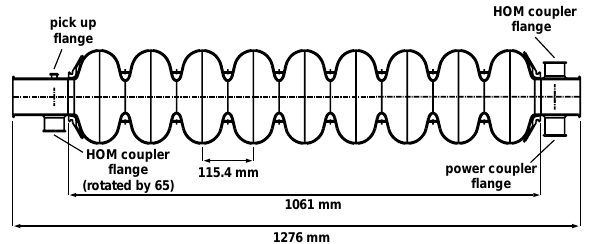
FIG. 5. Side view of the 9-cell TTF cavity with the ports for the main power coupler and two HOM